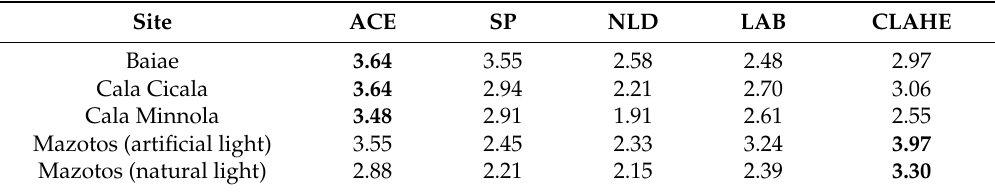
Table 6. Average vote divided by site and algorithm.